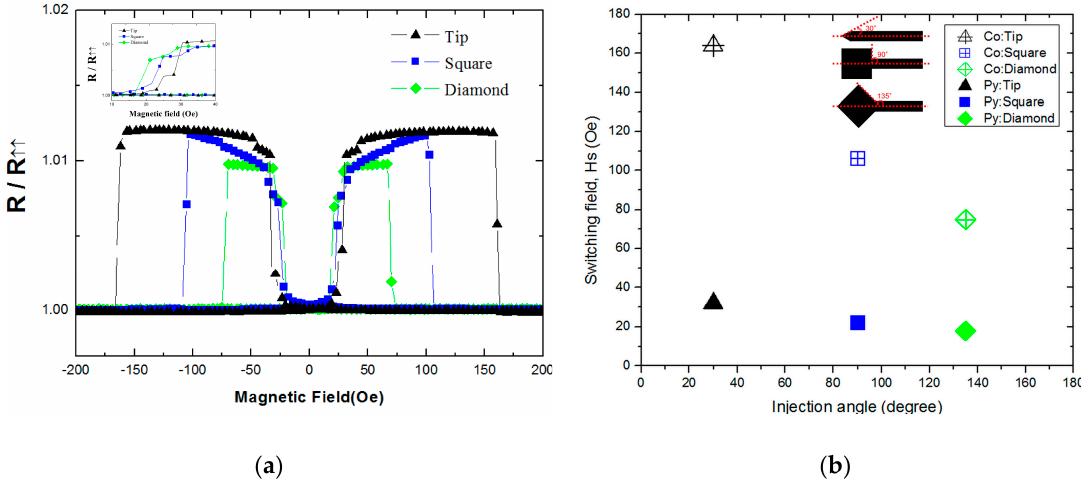
Figure 2. ( a ) Typical longitudinal MR loops of the nanostrips measured at room temperature. The inset illustrates the small magnetic field region. ( b ) The switching fields of Co and Py versus the domain wall injection angle. The inset illustrates the definition of the injection angle.